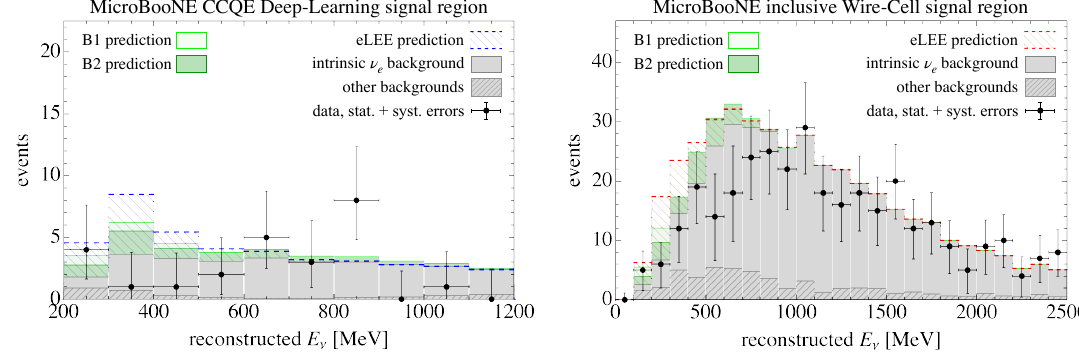
Figure 12 . Expected ν e event rates for two MicroBooNE searches: the CCQE Deep-Learning [133] (left) and the inclusive Wire-Cell [132] (right) signal regions. The gray histograms denote the expected backgrounds obtained by the MicroBooNE collaboration in each analysis. In particular, the intrinsic ν background rate shown in gray is the one expected in the SM and does not assume e BSM ν oscillations. The hatched histograms (blue on left panel and red on right panel) are the e ν e event rate prediction from the empirical LEE model used in the MicroBooNE analyses. The light and dark green histograms denote approximate ν event rate predictions from the B1 and e B2 quasi-sterile benchmarks (see text for details). Since intrinsic ν disappearance has not been e included in the background histograms, this effect has been absorbed in the green histograms for the B1 and B2 predictions. The data error bars include statistical and systematic